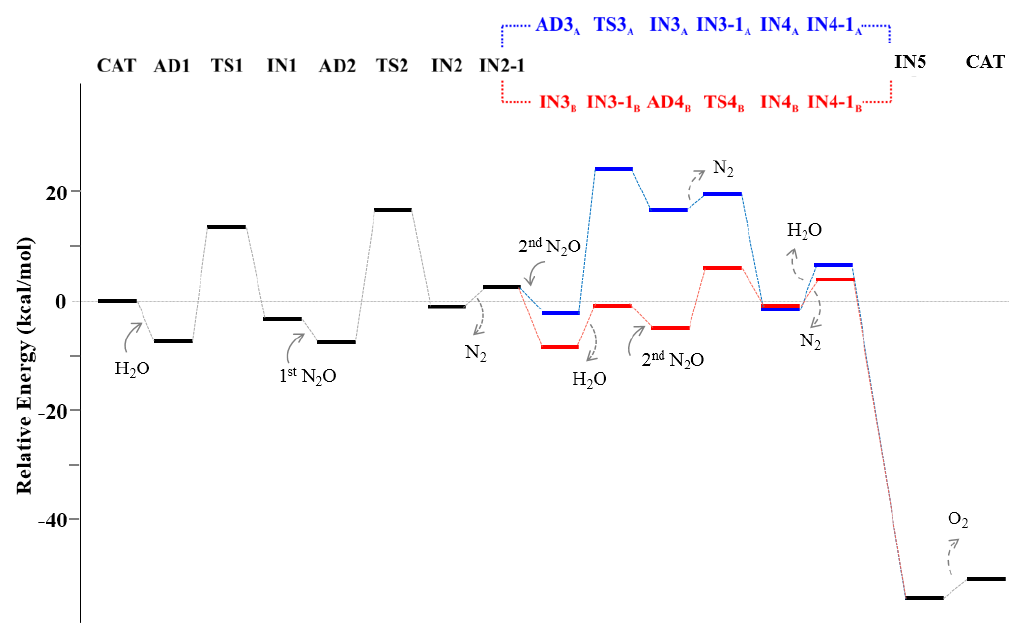
Figure 6. Full energy profile of N 2 O decomposition over the oxotitanium